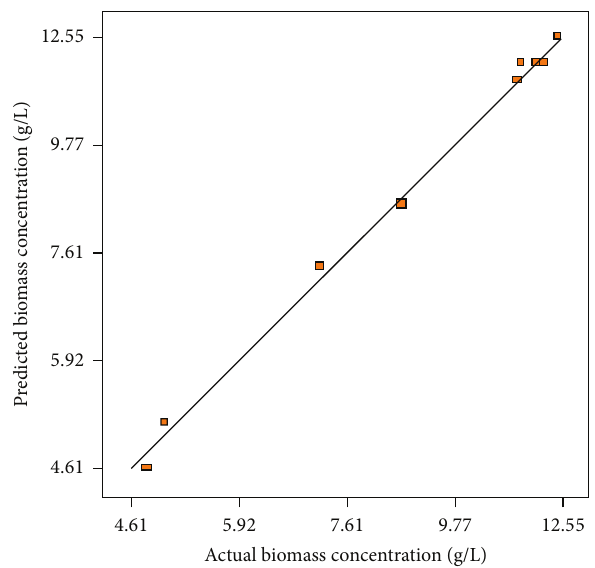
Figure 1: Experimental biomass concentration produced versus the predicted biomass concentration by the statistical model under operating conditions.